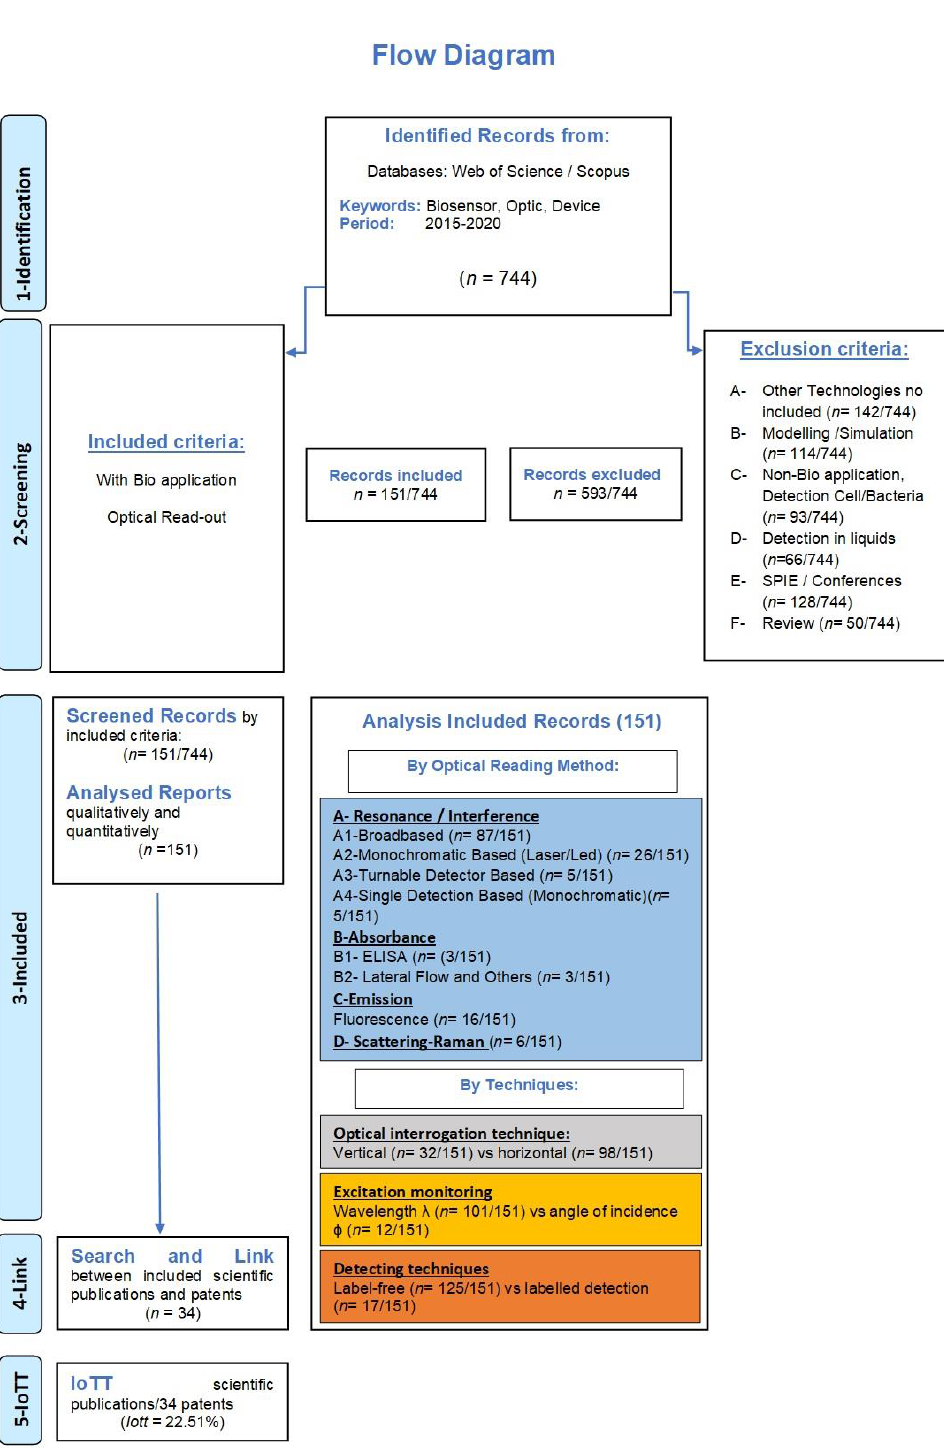
Figure 15. Flow diagram of the literature search illustrates the meticulous screening work in